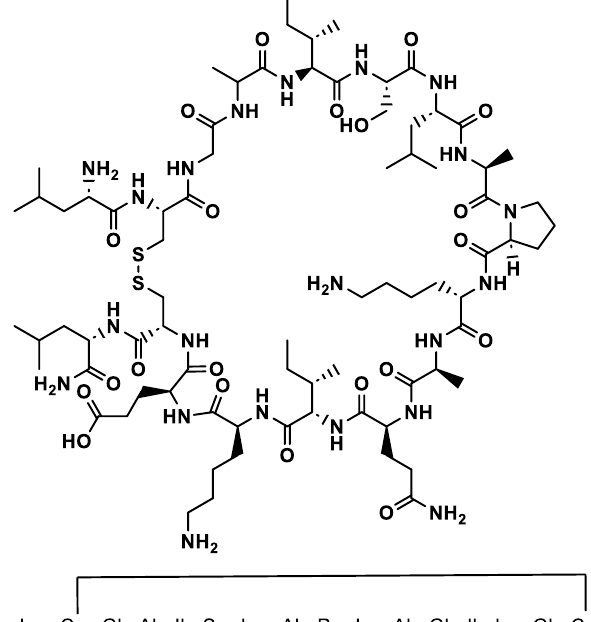
Figure 10. Sequence and structure of PD-1(122–138) C123-S137C [91].